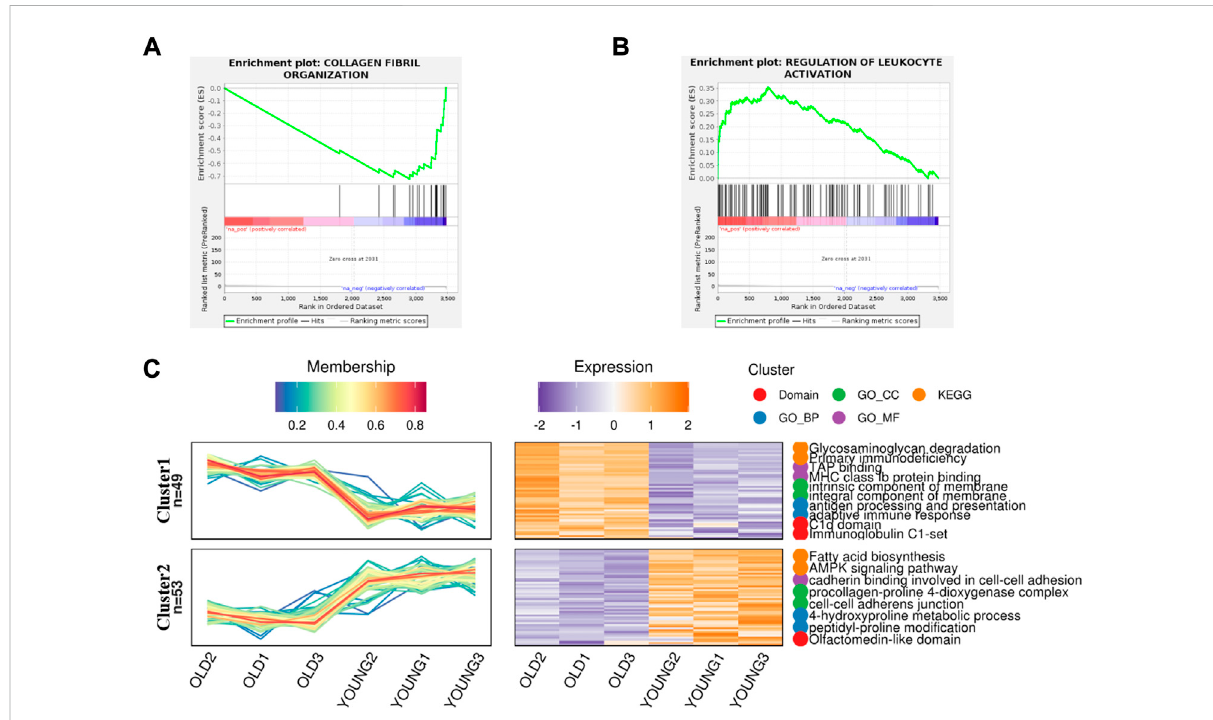
FIGURE 2 Gene Set Enrichment analysis and gene expression trend analysis in aging chondrocytes. (A) Gene set enrichment analysis of post-aging upregulated protein ( p < 0.01). (B) Gene set enrichment analysis of post-aging downregulated protein ( p < 0.05). (C) Trend analysis showed the related pathways involved in upregulating and downregulating proteins after